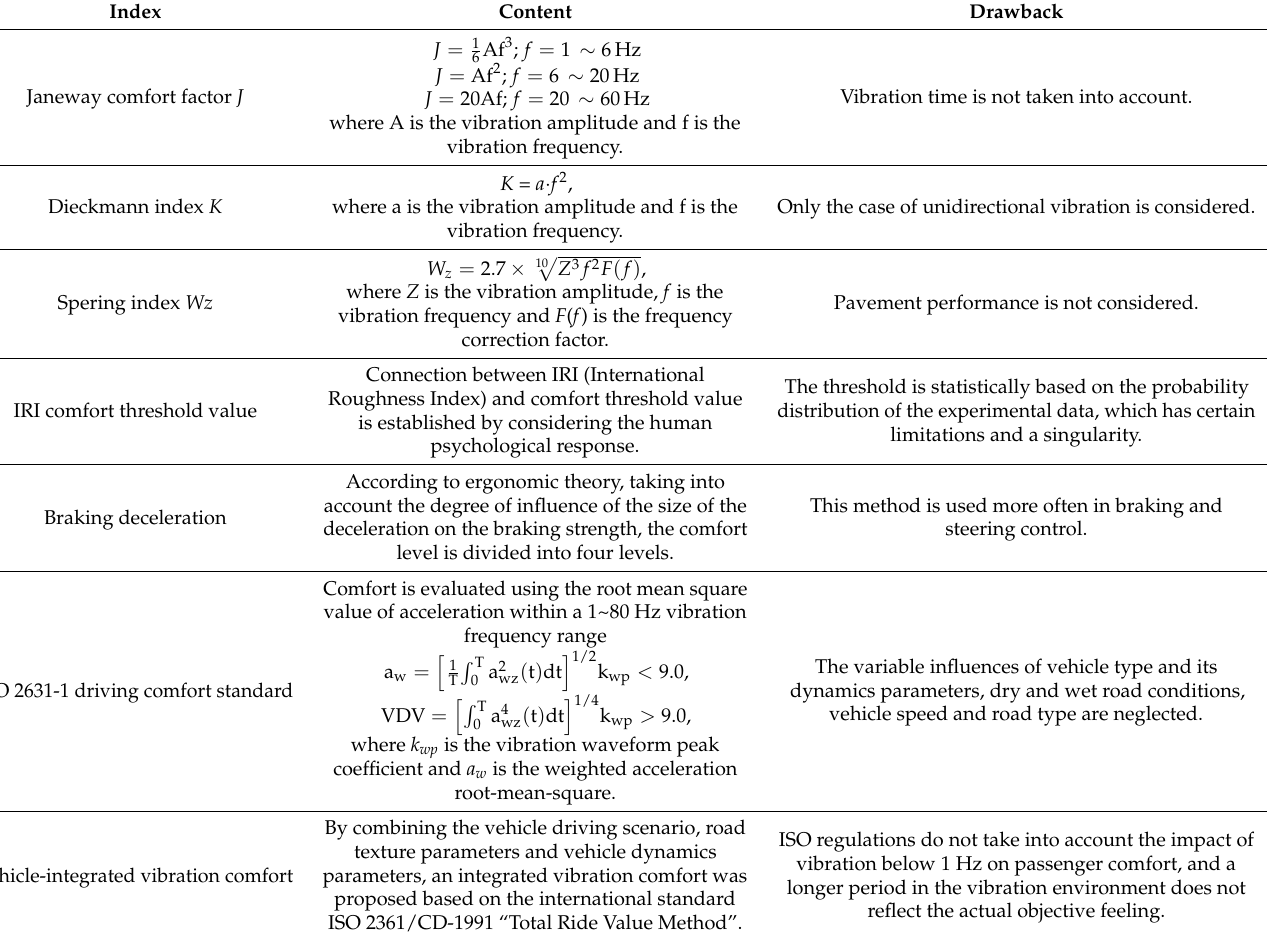
Table 1. Comparative analysis of existing comfort